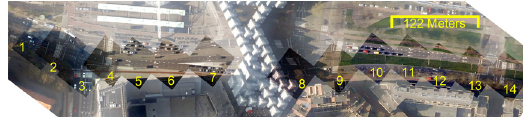
Figure 3. Visualization of the aerial image of the test area and cropped tiles.